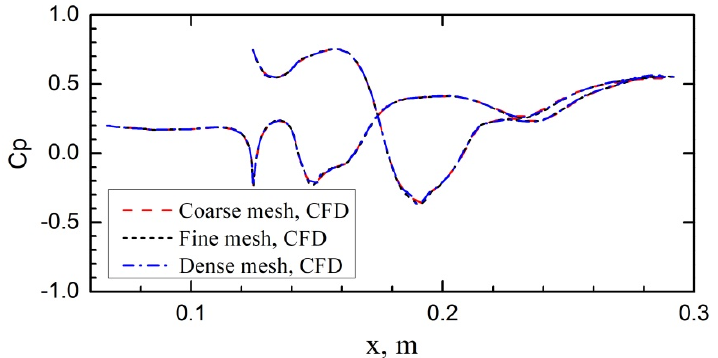
Figure 6. Surface static pressure distributions calculated with different-sized meshes at M = 0.7 and p AIP / p 0 = 1.18.